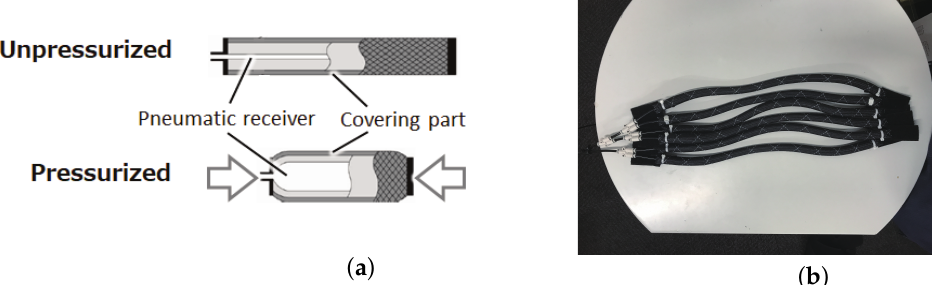
Figure 6. Internal structure of the McKibben-type artificial muscle and an overview of the pneumatic gel muscle (PGM): ( a ) structure of pneumatic artificial muscles and ( b ) image of the